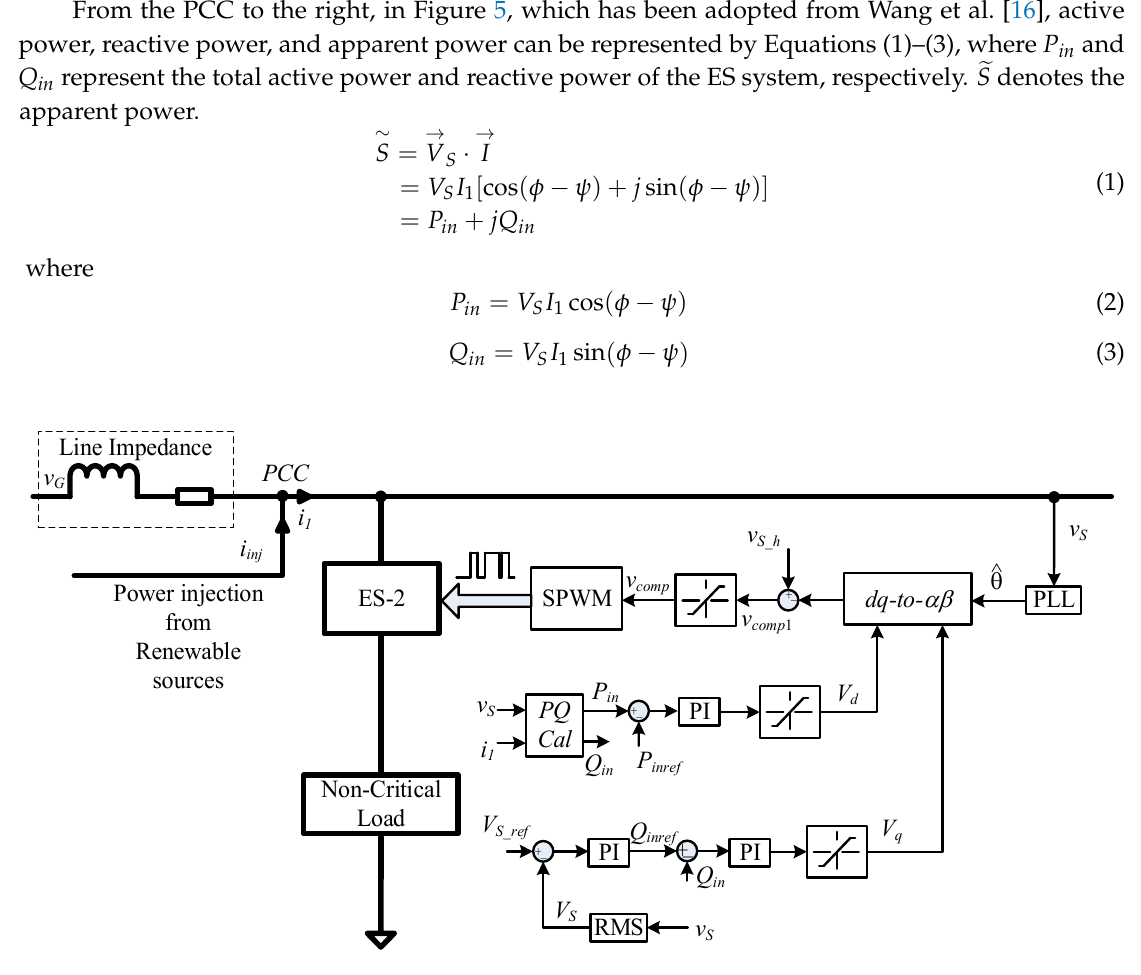
Figure 5. Power control scheme of ES-2 [16].